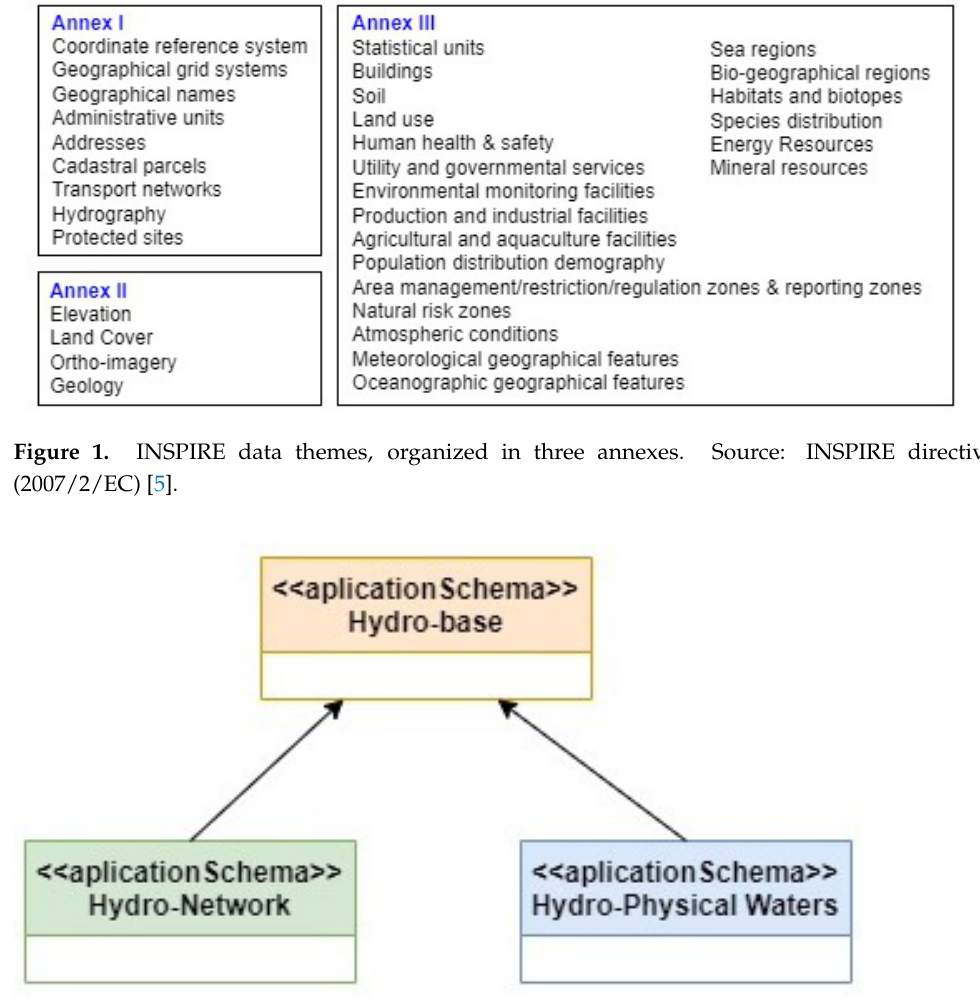
Figure 2. Hydrography package structure. Source INSPIRE consolidated UML Model (figure source